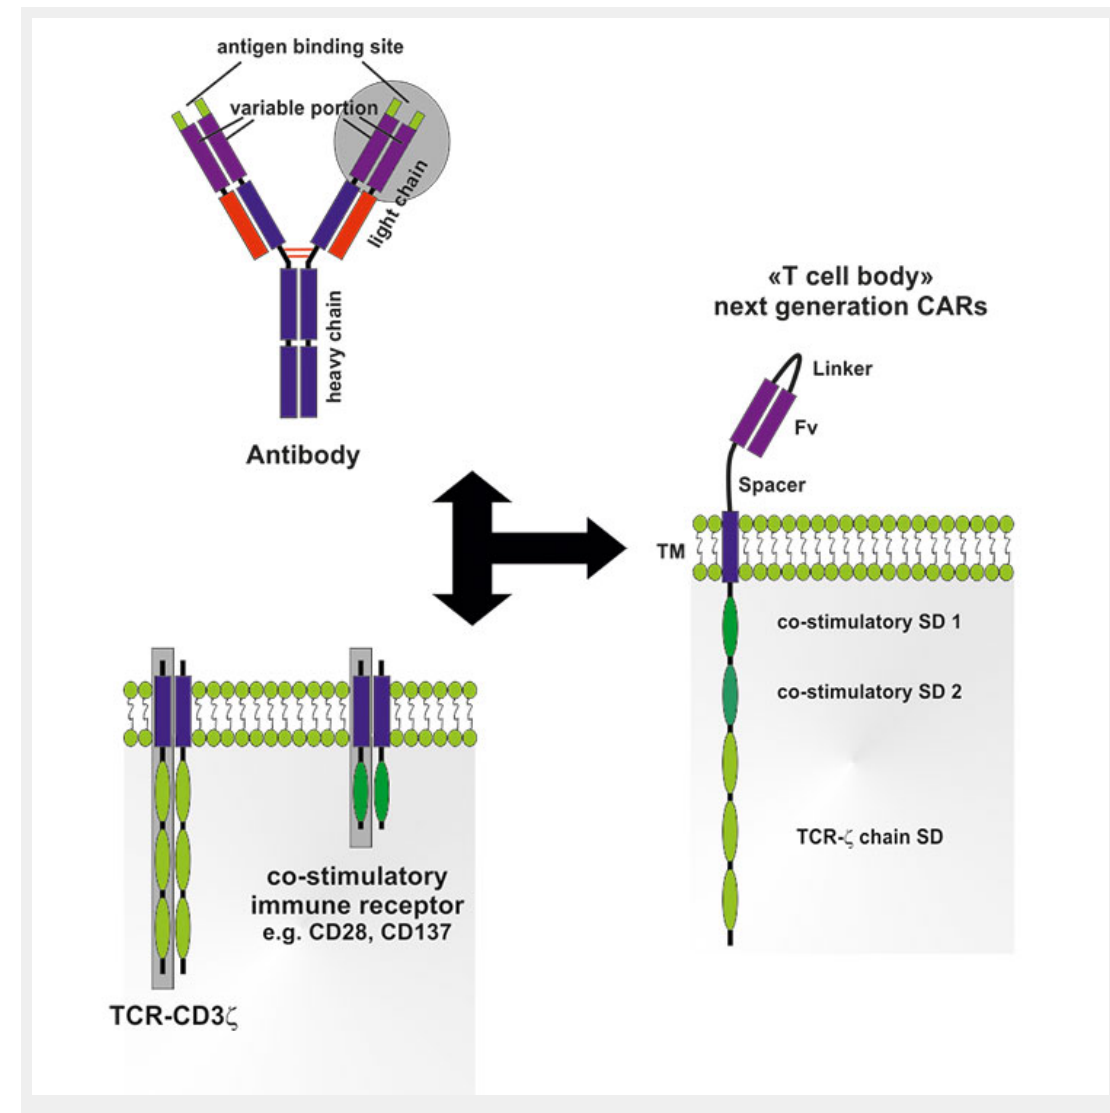
Structure and assembly of next-generation chimeric antigen receptors (CARs). CARs are comprised of the variable portion (Fv) from an antibody with a defined specificity for a tumour antigen linked via a transmembrane domain (TM) to intracellular signaling domains (SDs) from the T cell receptor (TCR)-complex (CD3ζ chain), as well as one or several SDs from co-stimulatory receptors (e.g. CD28, OX40, CD137). Consequently, T cells expressing genetically engineered CARs can be activated independent of antigen-presenting cells; recognition of tumour antigen by the Fv-portion results in full activation of T